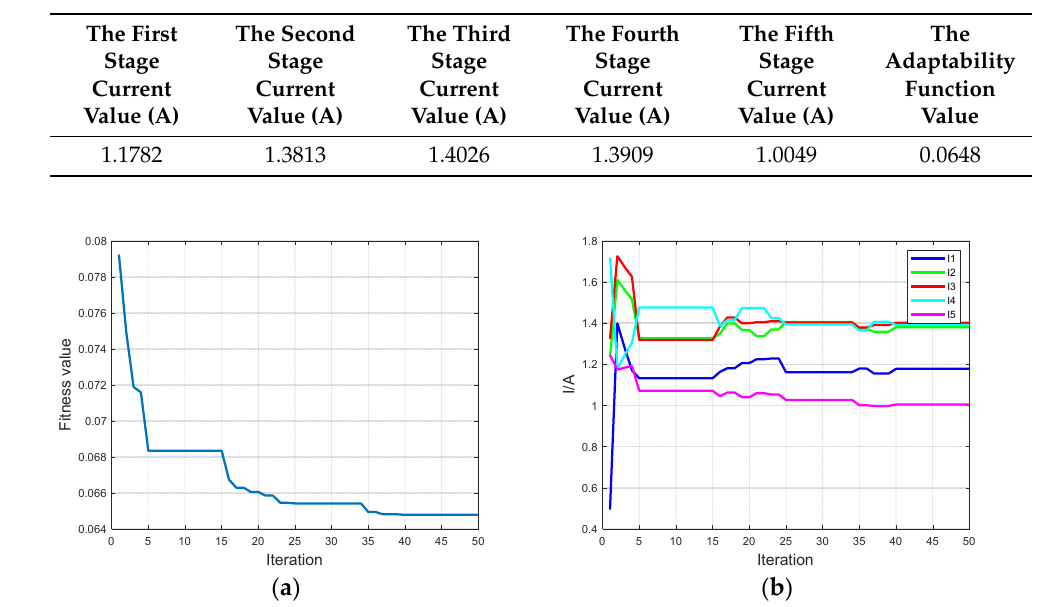
Table 3. Simulation results of five-stage constant current charging strategy.